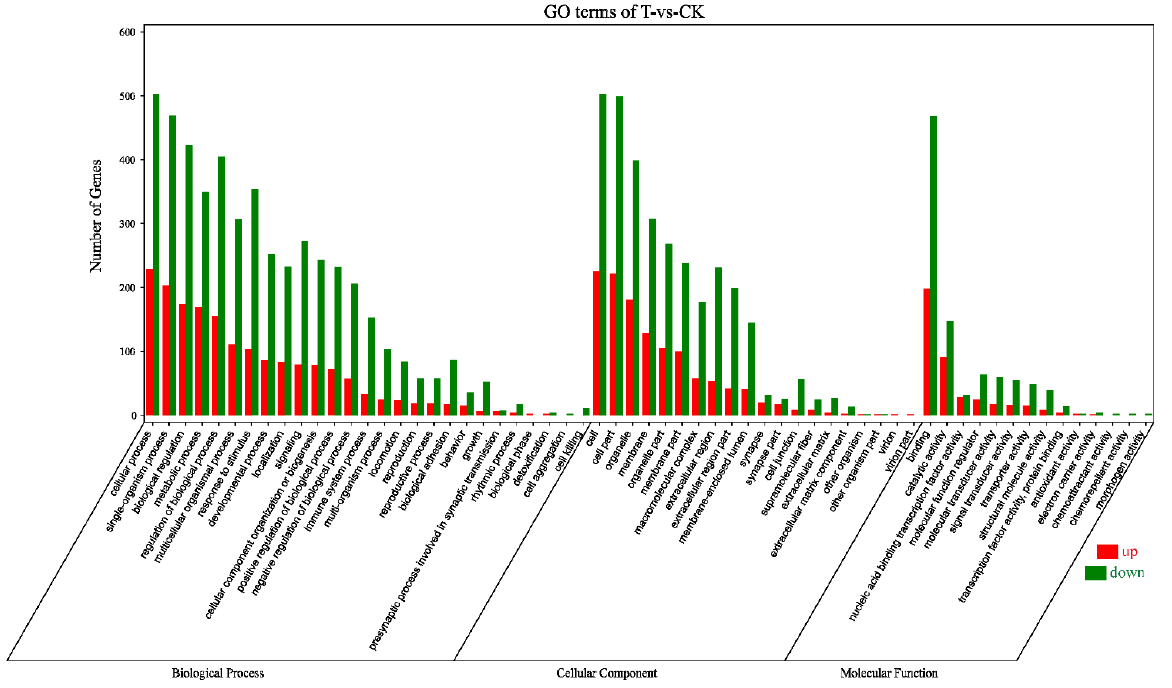
Figure 2. Gene Ontology (GO) terms categorization of 1037 DEGs. Number of genes: number of target genes in a term. Red, upregulation; green, downregulation; CK, the control group; T, the naringenin group.